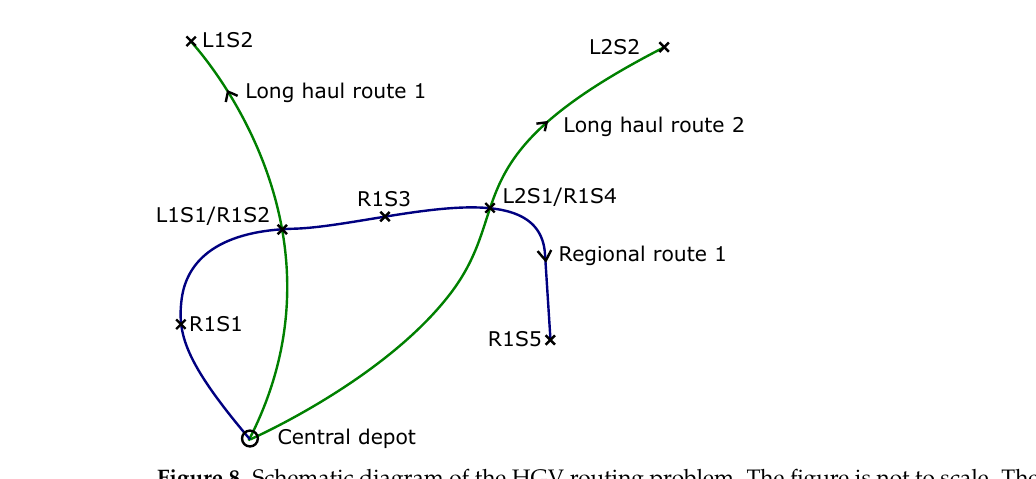
Figure 8. Schematic diagram of the HGV routing problem. The figure is not to scale. The distances between stops are described in the paragraph below.